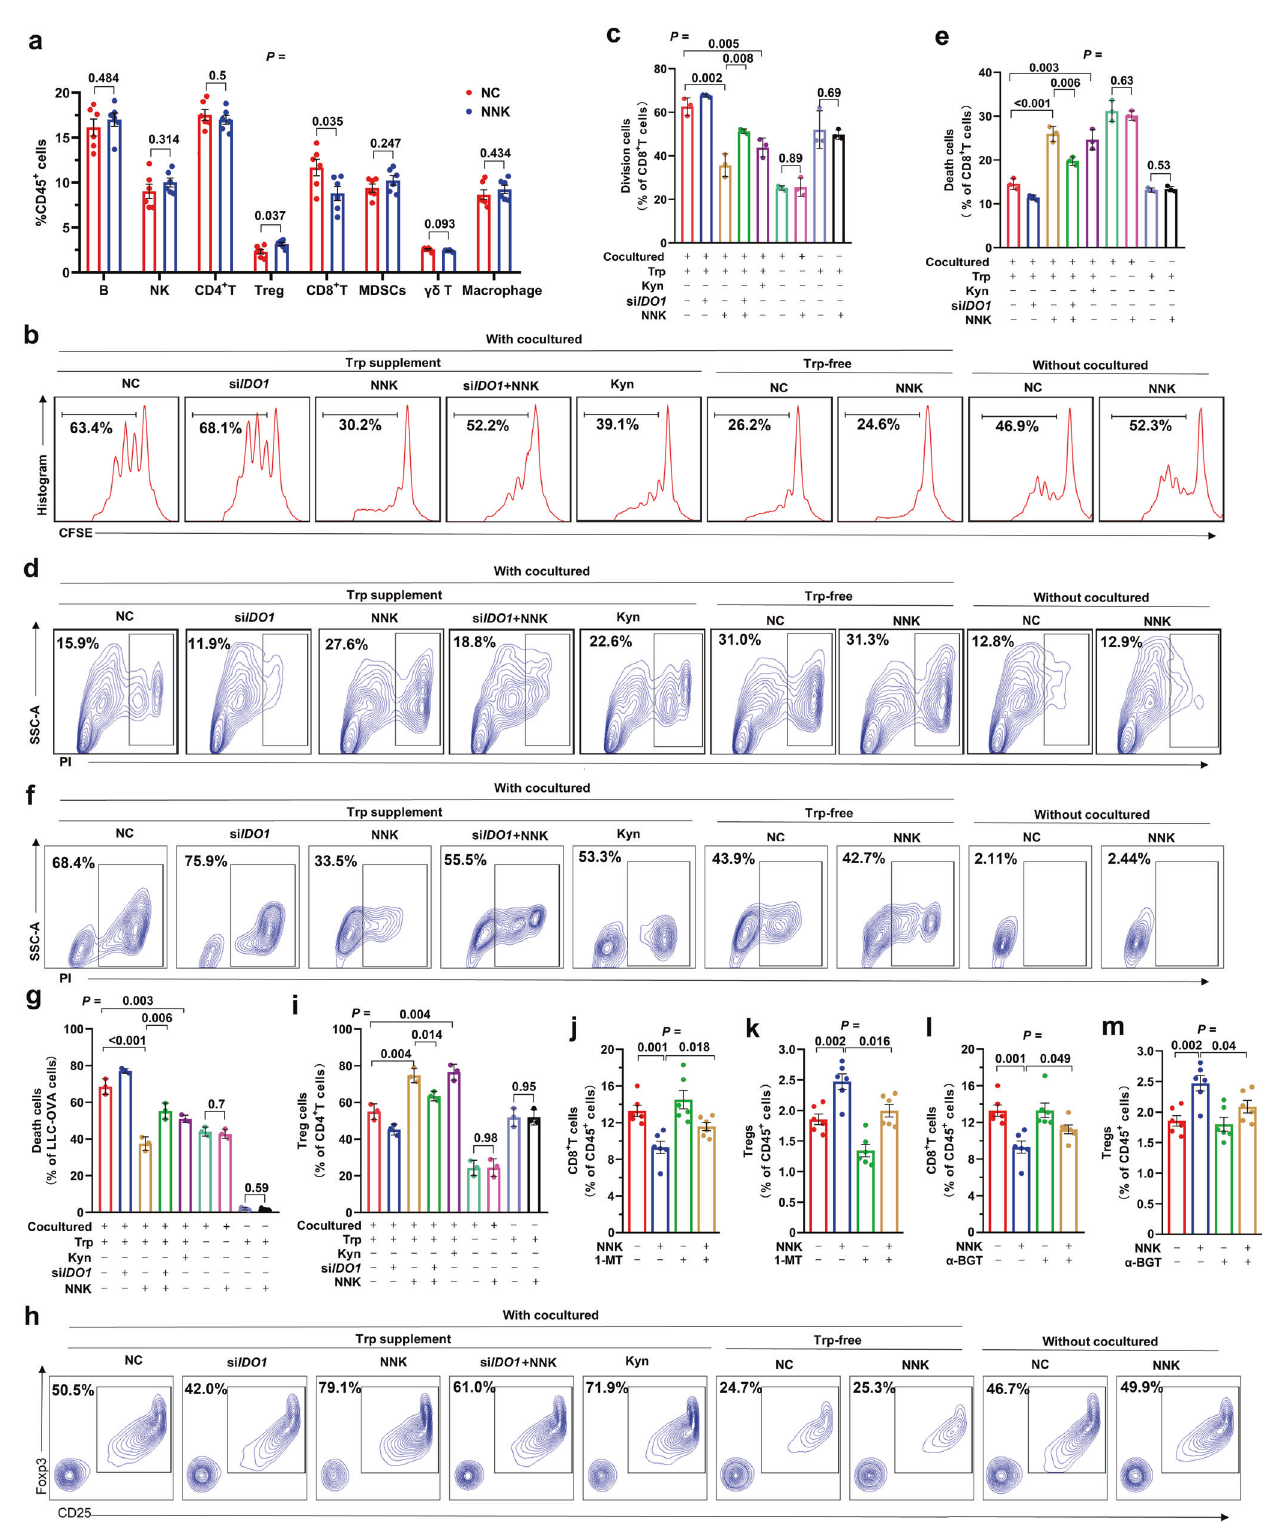
abnormal Trp metabolism in NSCLC may be the result of tobacco exposure, and the causes of other metabolic dysfunctions in cancer warrant further investigation. However, 26 (36.1%) of 72 smoker patients had a high Trp/Kyn ratio, possibly attributed to their metabolic activity for tobacco carcinogens and differences in